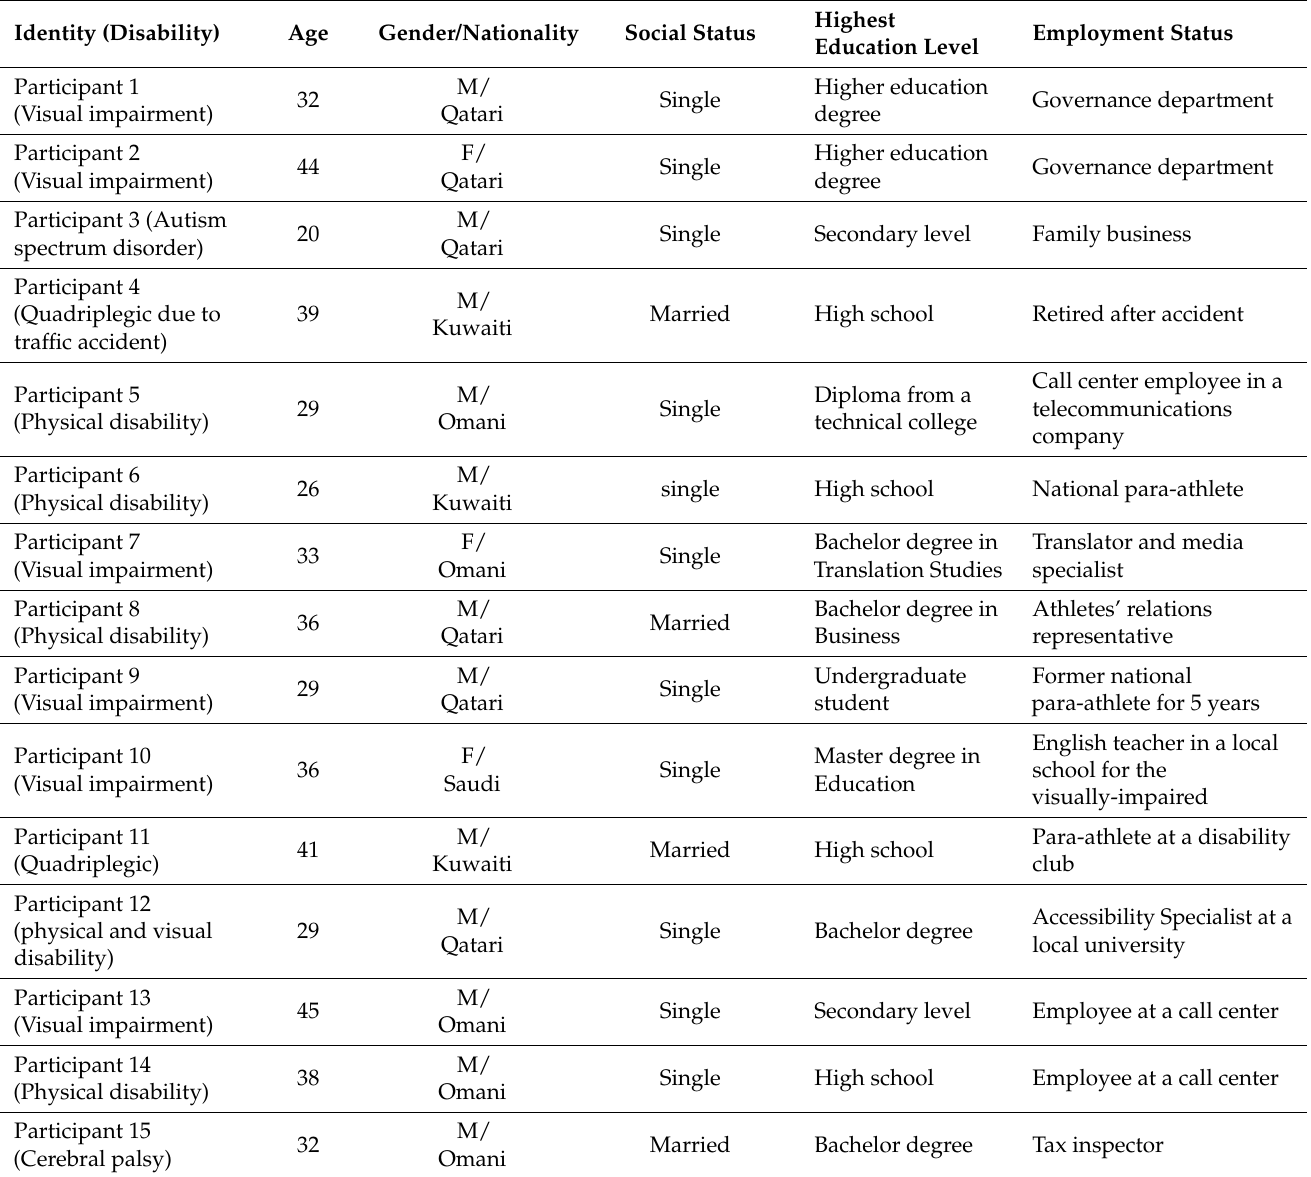
Table 2. Characteristics of participants at the point of